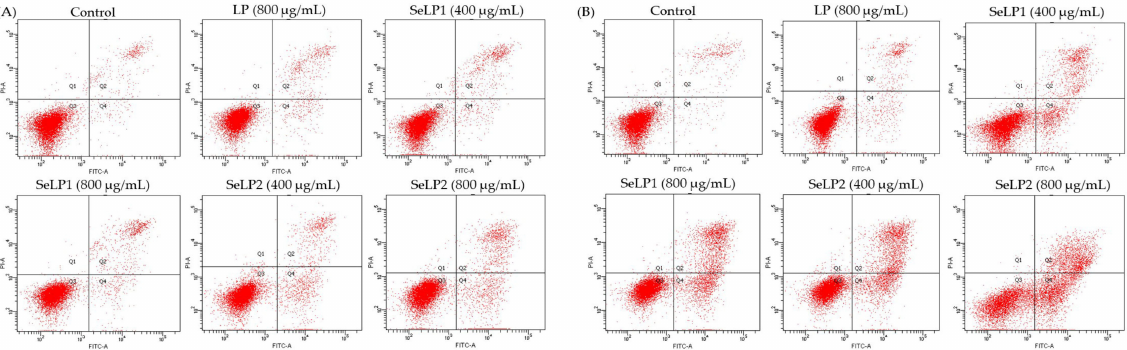
Figure 5. Apoptosis induction of longan polysaccharides (LP) and the selenylated polysaccharides (SeLP1 and SeLP2) toward HT-29 cells with treatment times of 24 ( A ) and 48 h ( B ). Cells in Q1–Q4 represent the necrotic, late apoptotic, intact, and early apoptotic cells, respectively. Table 2. The measured total apoptotic cells (%, Q2 + Q4) for HT-29 cells exposed to longan polysac- charides (LP) and two selenylated polysaccharides (SeLP1 and SeLP2). Total Apoptotic Proportion (%) Cell Group